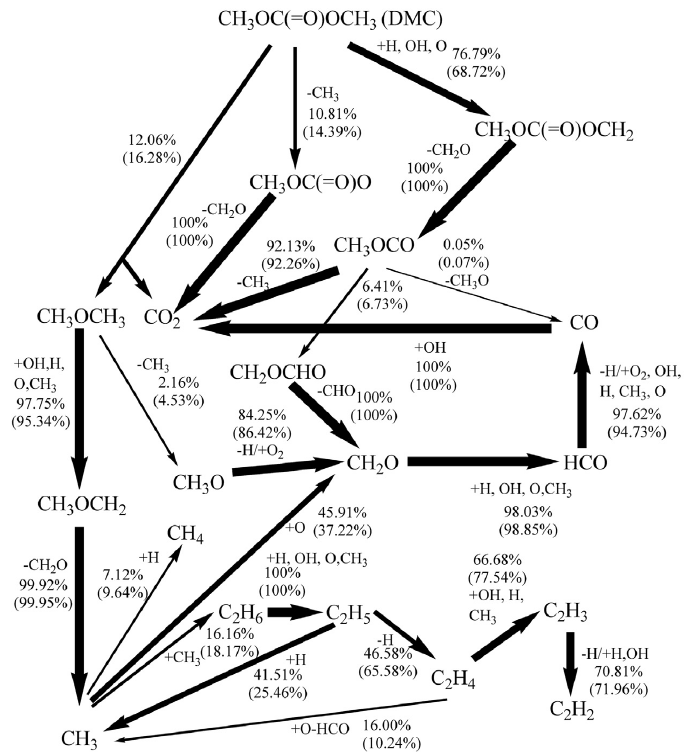
Fig.12. ReactionpathwaysforDMCinlow-pressurelaminarpremixedflamesbasedontheintegratedROPanalysisalongtheentireflame.Thethicknessofeacharrowrepresents Figure 9. DMC reaction pathways in low-pressure laminar premixed flames for equivalence ratios 1 the reaction flux of the corresponding reaction, and the numbers are percent contribution to the consumption of the species on the source side of the arrow in the φ = 1.0 flame and φ = 1.5flame(inparenthesis). and 1.5 (in parentheses)